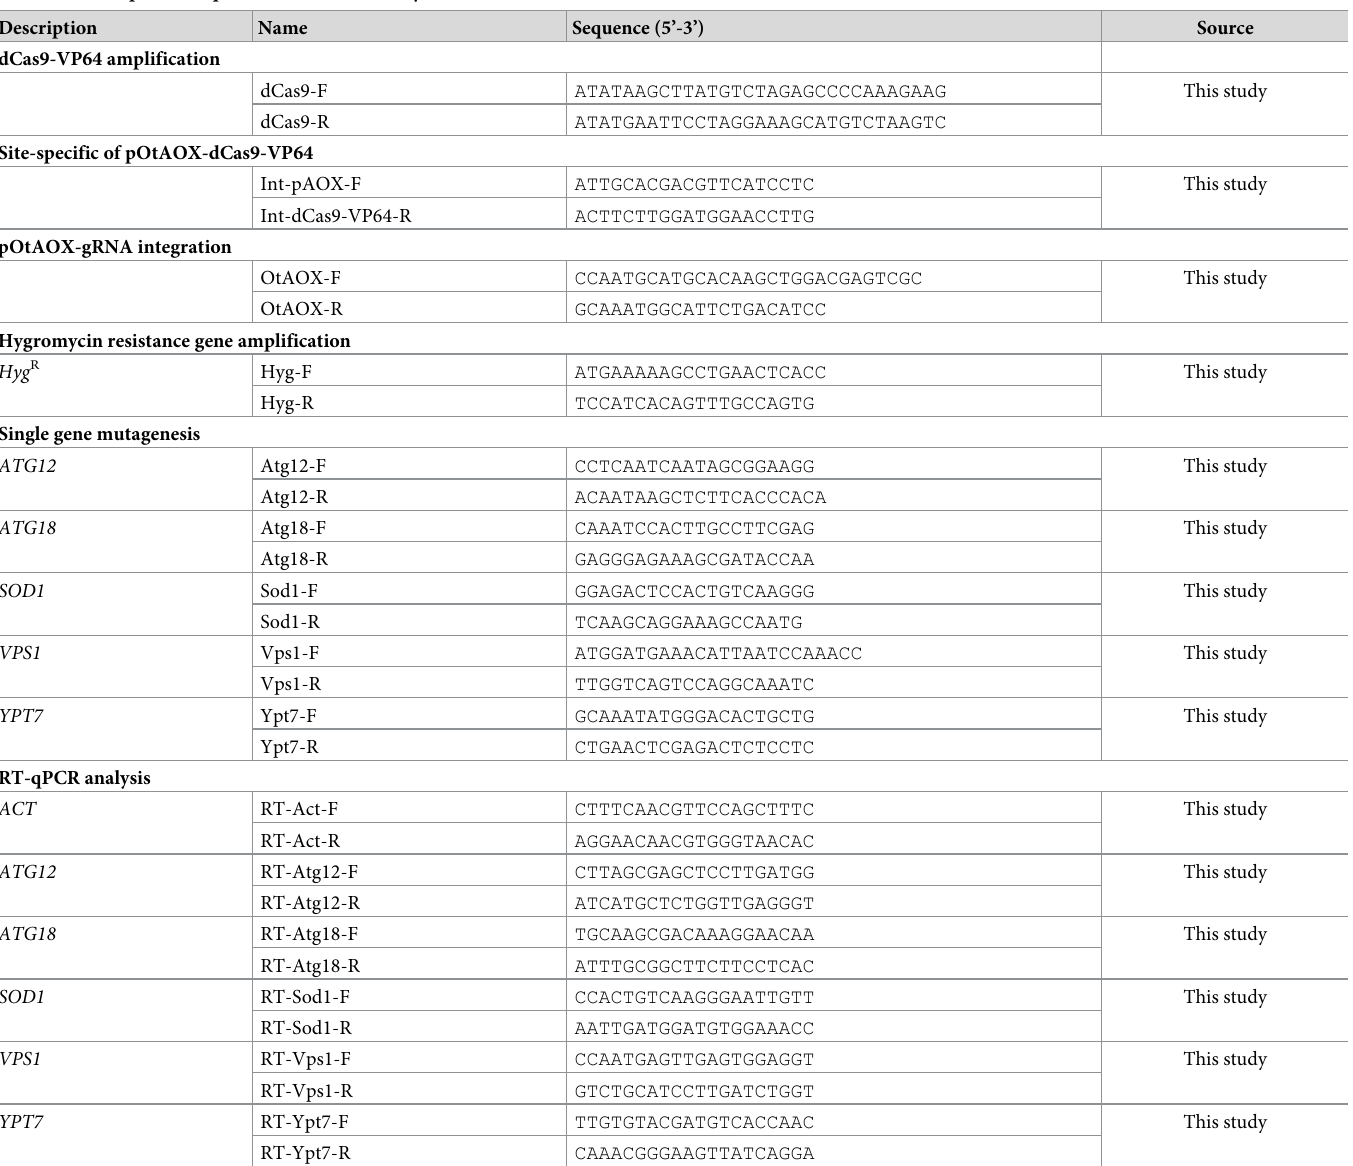
Table 2. List of primer sequences used in this